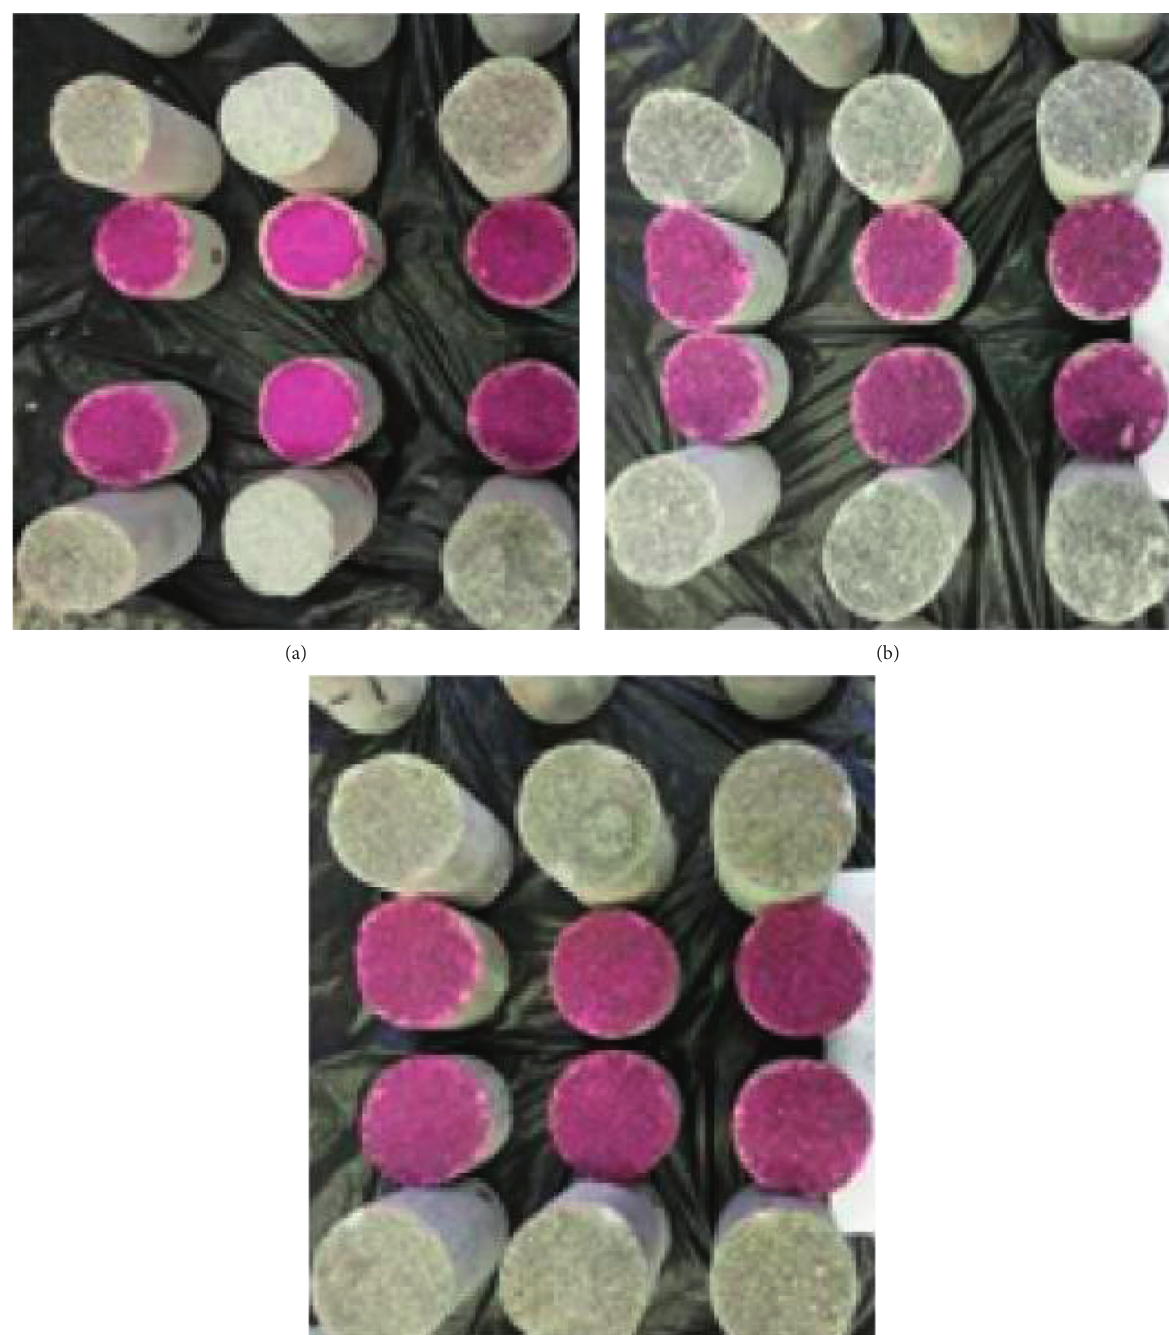
Figure 2: Samples after testing for carbonation evaluation: (a) reference; (b) fly ash; (c) active